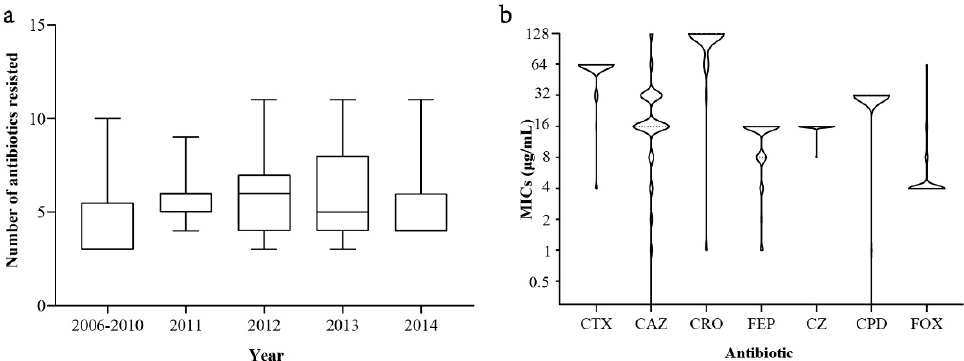
Figure 4. The total number of antibiotics to which the Salmonella isolates were resistant ( a ) and the minimum inhibitory concentrations (MICs; b ) of cephalosporins for ESBL-producing Enteritidis concentrations (MICs; b ) of cephalosporins for ESBL-producing Enteritidis isolates recovered from different years. CTX: isolates recovered from different years. CTX: Cefotaxime; CAZ: Ceftazidime; CRO: Ceftriaxone;